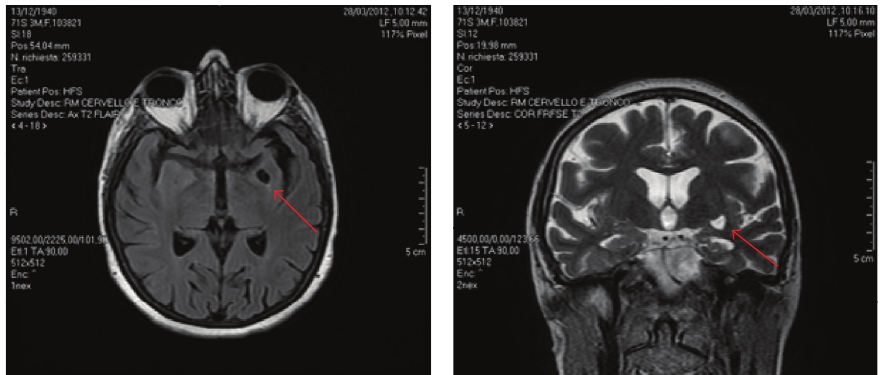
Figure 1: An expanded round cavity with liquid content and thin halo of gliosis was evidenced with MRI (indicated with arrows).